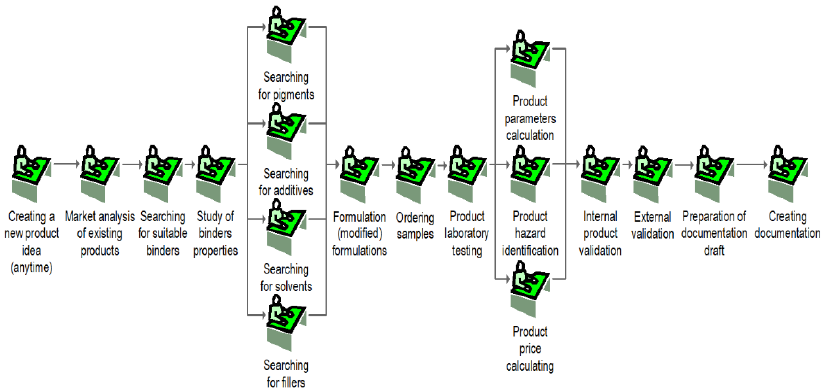
Scheme 1. The model overview of the conventional new product development process.